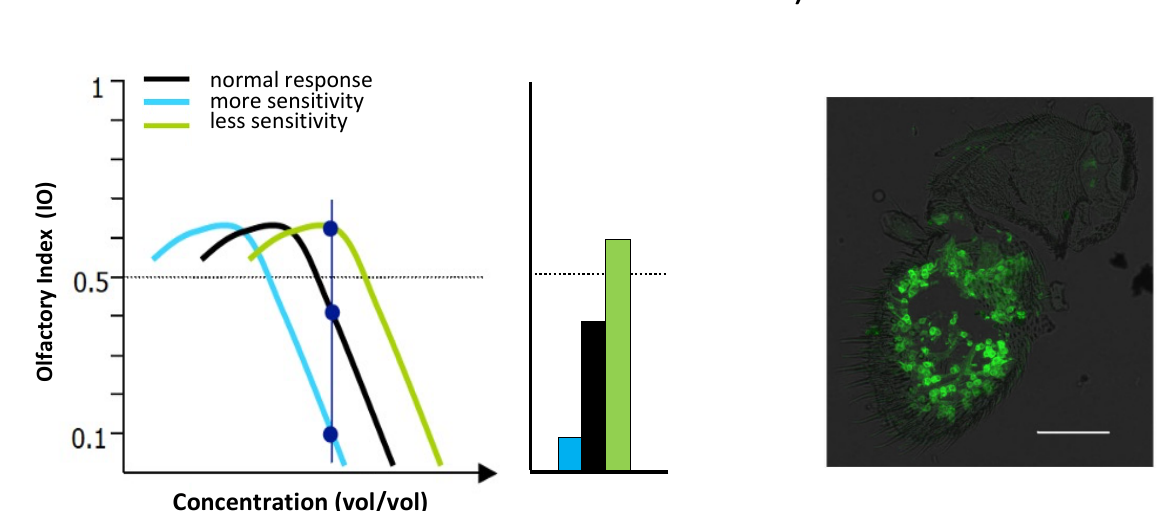
Figure 3. Representative dose–response curve in the T-maze. ( A ) Representation of the typical dose-response curve in the T-maze in response to increasing concentrations of odor ( left ). Testing a single odorant concentration, corresponding to the vertical blue line in the dose–response curve, in the repellent region for normal flies (black) allows detecting changes in sensitivity in both directions, either less sensitive flies (green) or more sensitive flies (blue). IO mean values are represented in the histogram (right). Note that in this case the higher IO values correspond to diminished sensitivity and the lower values to increased sensitivity. ( B ) Representative immunostaining of the main olfactory organ of Drosophila where the OSNs expressing the Orco co-receptor cover the entire surface of the third antennal segment. Green Fluorescent Protein (GFP) directed expression in these OSNs is shown in green. Scale bar, 30 µm.